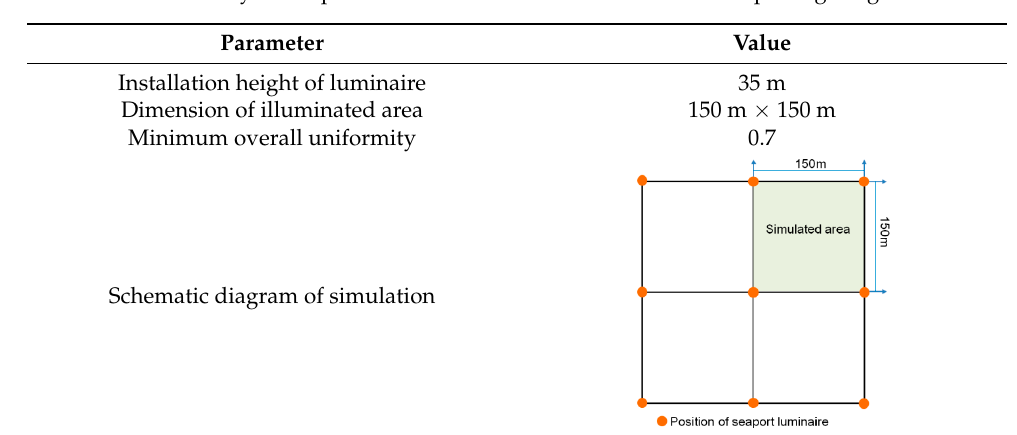
Table 1. The boundary and input conditions used in the simulation of seaport lighting.